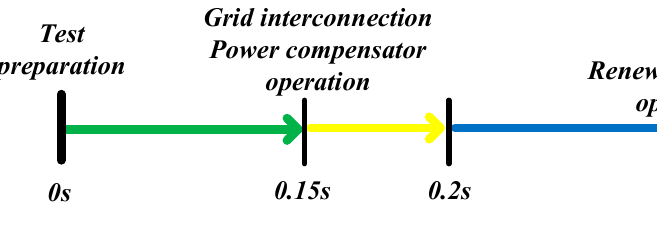
Figure 27. OPAL-RT test step.